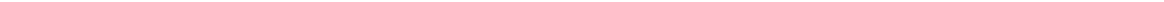
Fig. 2 TCP and TCA mice develop a CLL-like disease. Conditional B cell-speci fi c deletion of Trp53 and Atm in TCL1 -driven murine CLL leads to the development of a disease displaying morphological and histological features, as well as surface marker pro fi les consistent with a CLL-like disease. a H/E stainings of spleens, lymph nodes, bone marrow, and blood smears of TC, TCA, and TCP mice and WT controls. Scale bars overview: 200 µ m; scale bars inserts: 25 µ m. b Representative H/E and Ki67 stainings of spleens isolated from animals with CLL-like and transformed disease ( RS Richter ’ s syndrome). Lymphomas of Myd88 condp.L252P/wt ;R26 LSL.BCL2/wt ;Cd19 Cre/wt 22 and E µ TCL1;Cd19 Cre/wt ;AKT C (Al-Maarri et al., unpublished) were included as an internal reference. Scale bars overview: 50 µ m; scale bars inserts: 20 µ m. c Quanti fi cation of the Ki67 stainings from untransformed and transformed animals ( n = 5 for TC, TCA, and TCP, n = 3 for RS cases). d Quanti fi cation of the frequency of Richter transformation in the different mouse lines (TC: n